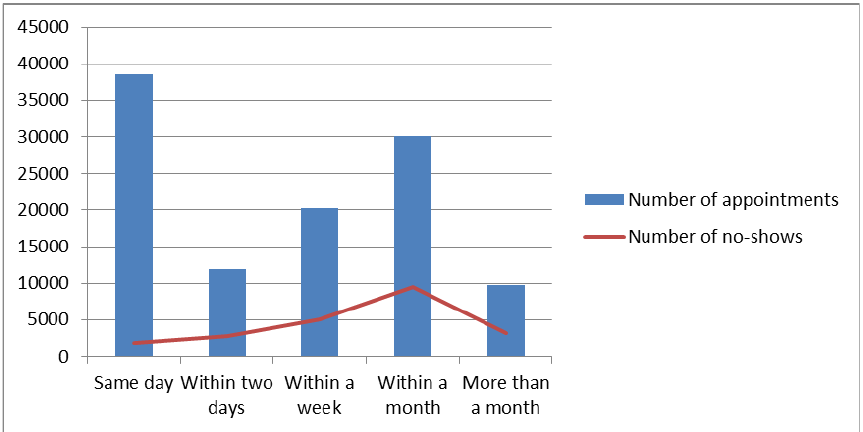
Figure 4. Distribution of no-show based on waiting interval